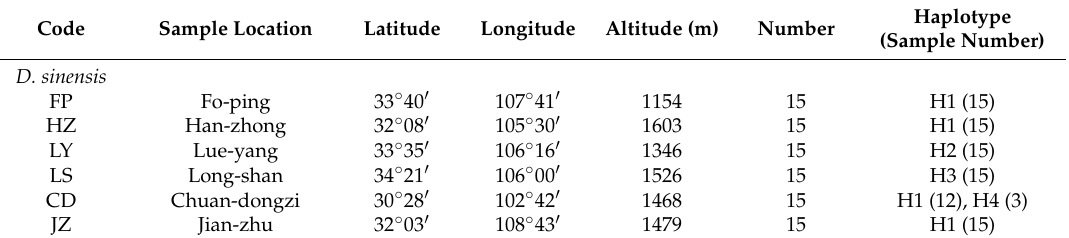
Figure 1. The distribution of nine chloroplast DNA haplotypes identified within 18 Dipteronia Oliv. Haplotype colors corresponds to those in Figure 2. The blue and red dotted areas represent the distribution areas of D. sinensis and D. dyeriana , respectively. Population abbreviations correspond to those given in Table 1. Table 1. Details of sample locations (taken from GPS coordinates), sample sizes, and chloroplast DNA haplotype frequencies for 18 populations of Dipteronia Oliv. in China.